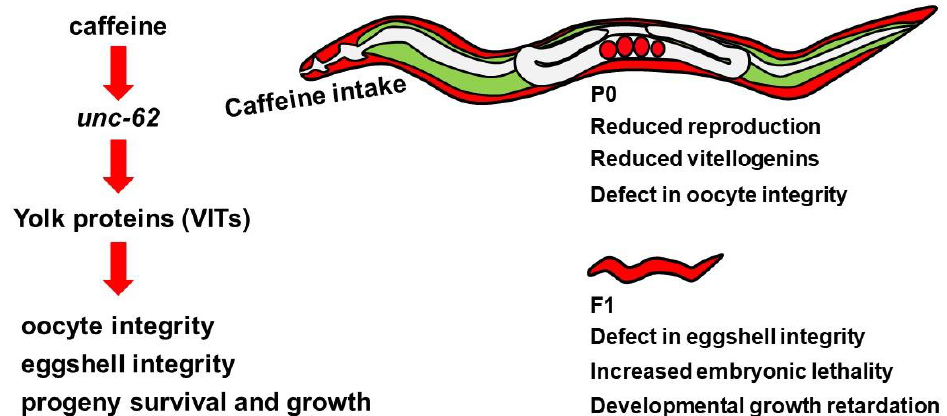
Figure 8. Model of the intergenerational effects of maternal caffeine intake in Caenorhabditis elegans . Caffeine intake decreased the production of yolk proteins by reducing unc-62 expression. The decreased levels of yolk proteins disrupted oocyte and eggshell integrity and induced embryonic lethality and growth retardation of the next generation.